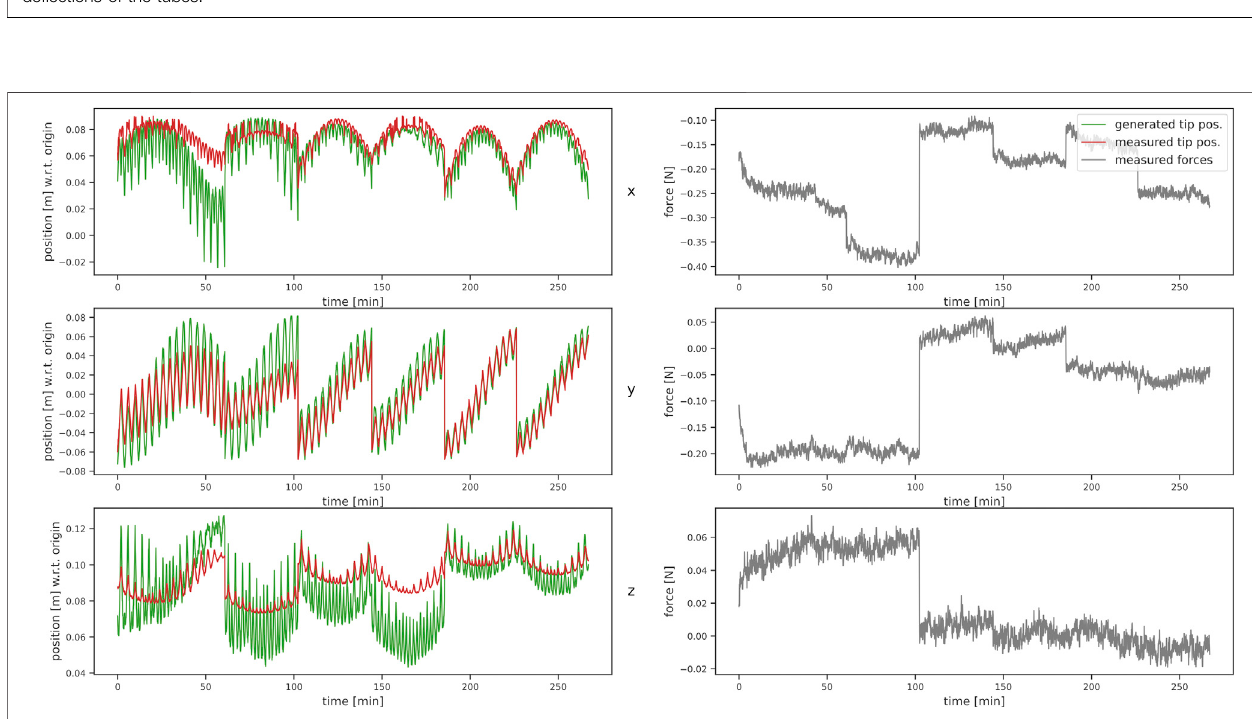
FIGURE6| Comparisonofmeasured(red)andestimated(green)tippositionsontheleft,withthemeasuredforceinx-,y-,andz-directionofthebaseframeonthe right, respectively.